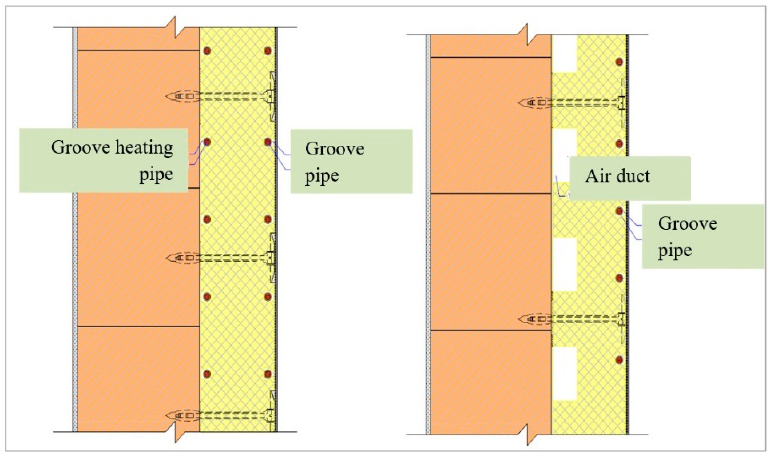
Figure 20. Application of the contact insulation system by means of thermally active panels, with a combined function of ATP and register collecting solar energy or energy of the surrounding [23].